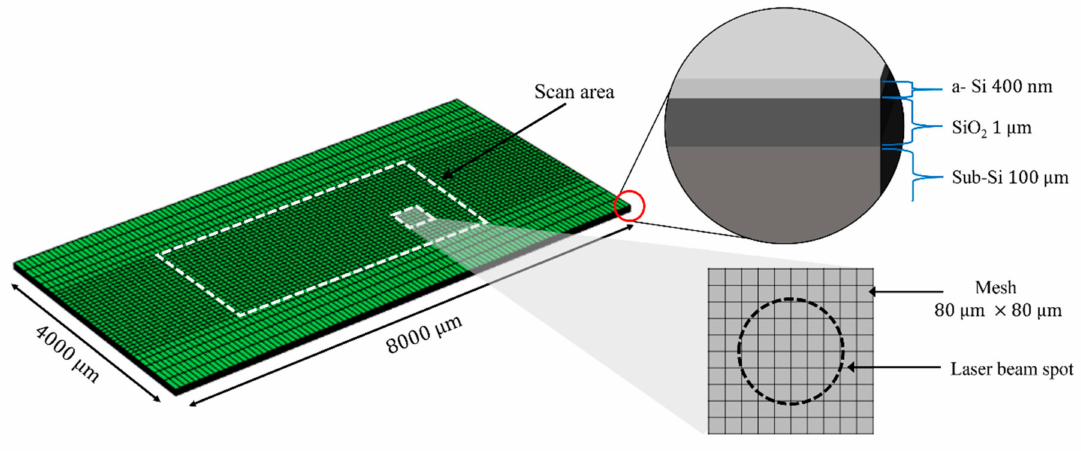
Figure 1. Computational domain used in